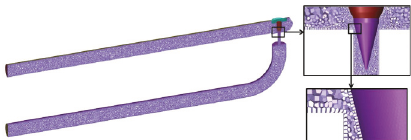
Figure 2: Meshes of EEV with local zooming of the throttle